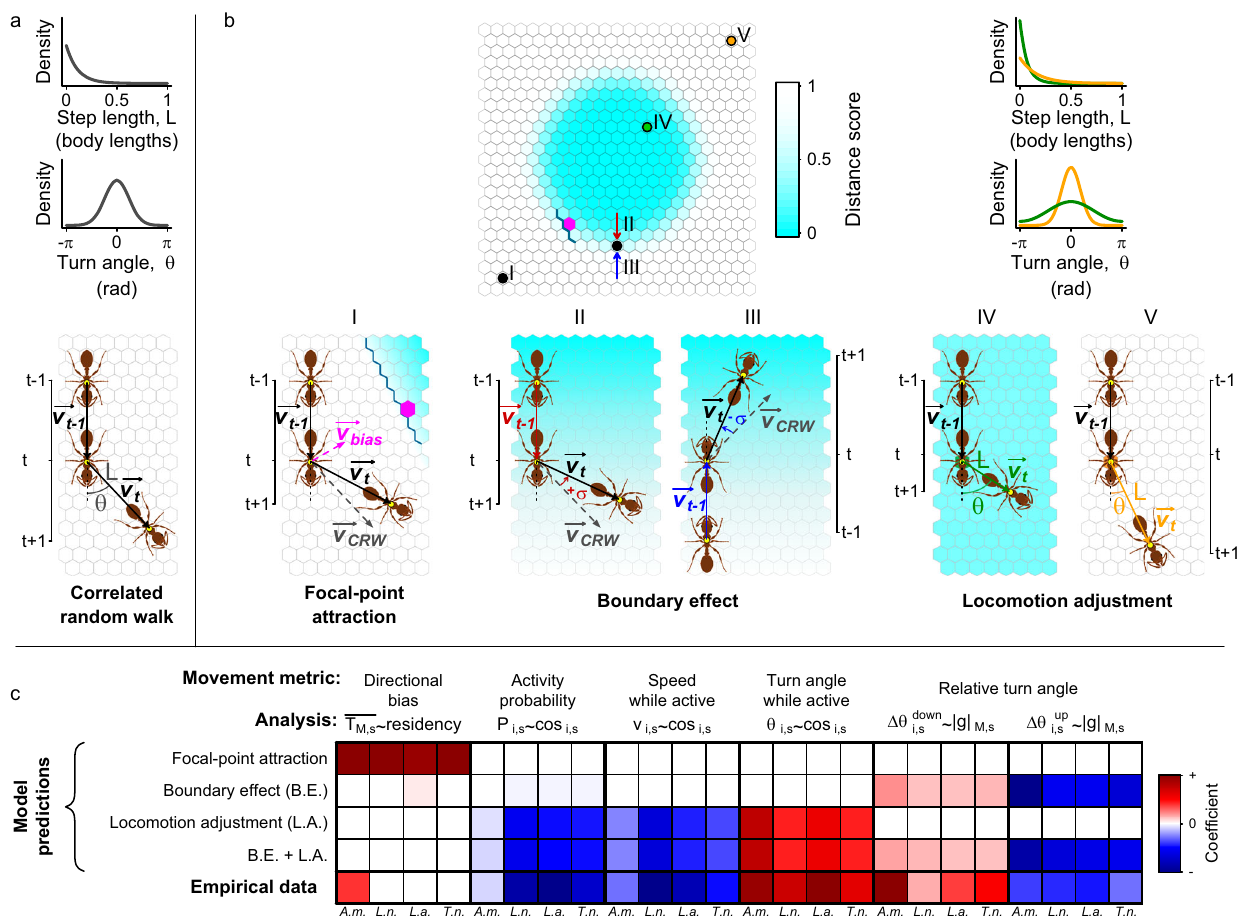
Fig. 9 | Agent-based modelling of individual movement. a All simulation trajectories were based on the correlated random walk (CRW) model. A CRW trajectory is ! , produced by randomly drawing a step length L and a turn angle θ from an exponential and a wrapped normal distribution, constructed from a sequence of vectors v t respectively. b Theuppermaprepresentsthenestgriduponwhichtrajectoriesaresimulated.Thenestincludestwooverlapping ‘ spatialmodules ’ (centralandperipheral), characterisedbya ‘ distancescore ’ increasingnon-linearlywiththedistanceofeachsitetothenestcentre.Tomodelthethreemovementmechanisms,theCRWismodi fi ed (cid:1)(cid:1)(cid:1) ! (cid:1)(cid:1) ! asfollows.Inthefocal-pointattractionmodel(pointIinmap),theCRWvector v CRW ismodi fi edbyaddingabiasvector v bias ,whichpointstowardstheclosestpointonthe border of the individual ’ s primary module (magenta cell). In the boundary effect model (points II – III), the CRW is modi fi ed in the vicinity of the module boundary by increasing(decreasing)theCRWturnangleby σ whenapprochingtheboundaryfromtheinside(outside).Inthe locomotionadjustment model,the L and θ distributionsare modi fi ed according to location, so individuals make shorter (larger) steps and larger (smaller) turns when inside (outside) their primary module (points IV & V, green & orange distributions, respectively). c Comparison between empirical and simulated trajectories. Grouped columns indicate the fi ve movement metrics described in the main text, and letters below individual columns give species name abbreviations. Formulas provide a brief description of the statistical model conducted for each movement metric, and cell colours encode the sign and value of the coef fi cient of the predictor in the statistical model (see text for the model de fi nitions). To facilitate comparisons within metrics, the coef fi cients are normalised by the maximum absolute value of all coef fi cients for each metric. Source data are provided as a source data fi